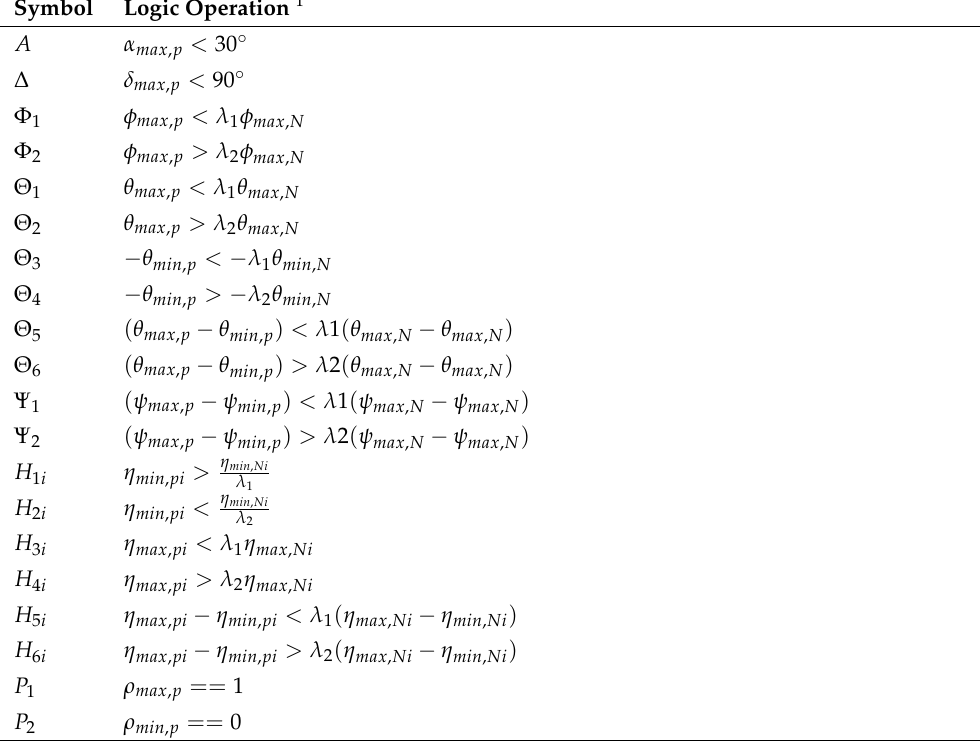
Table A2. Symbol meanings in